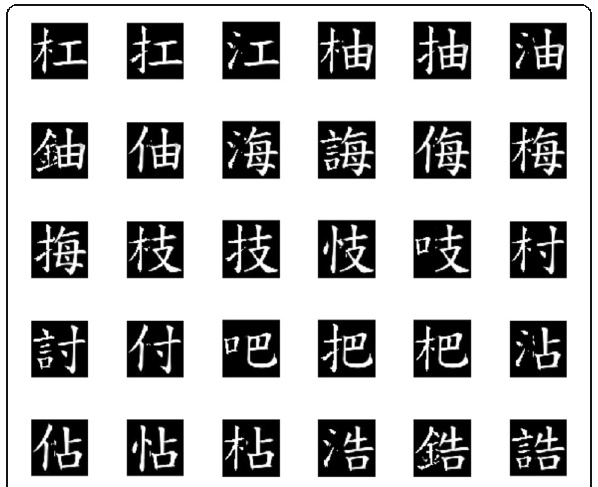
Fig. 2 Examples of training samples (binary images of Chinese characters) used in our experiments.